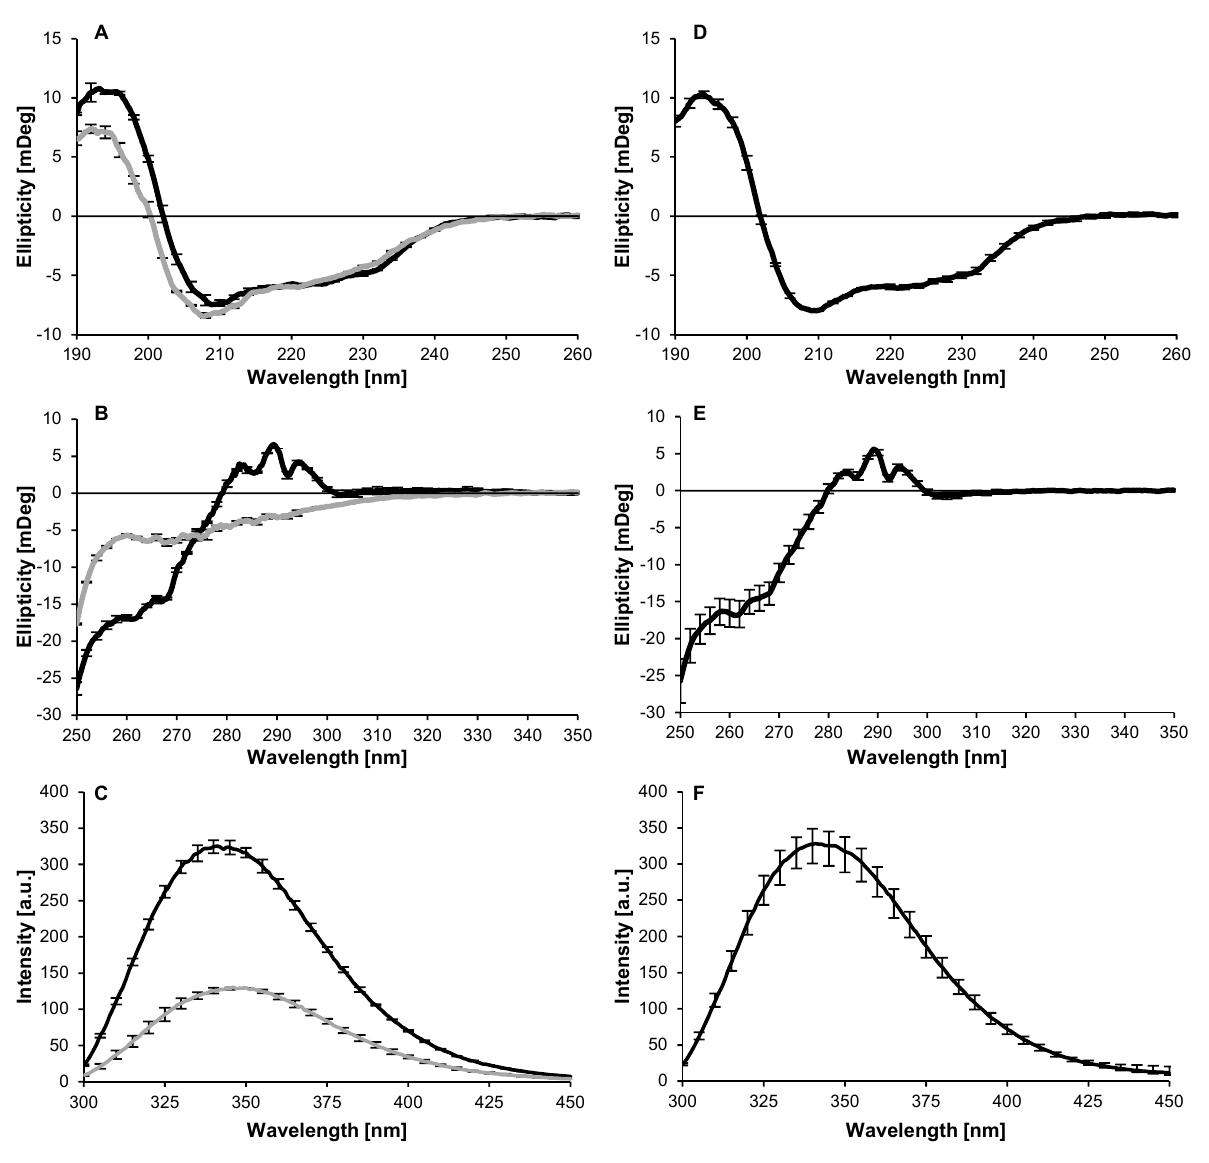
Figure 1. Far-UV ( A , D ) and near-UV ( B , E ) CD and intrinsic fluorescence ( C , F ) spectra of lysozyme at pH 5.7 and 20 ◦ C or 77 ◦ C → 20 ◦ C (black) and 77 ◦ C or 77 ◦ C after 30 min (grey; A – C ), and spectra averaged for all (un-)heated lysozyme variants ( D – F ; heated for 0–120 min at 77 ◦ C) at pH 5.7 and 20 ◦ C. The data in the panels are average values with the error bars indicating the standard